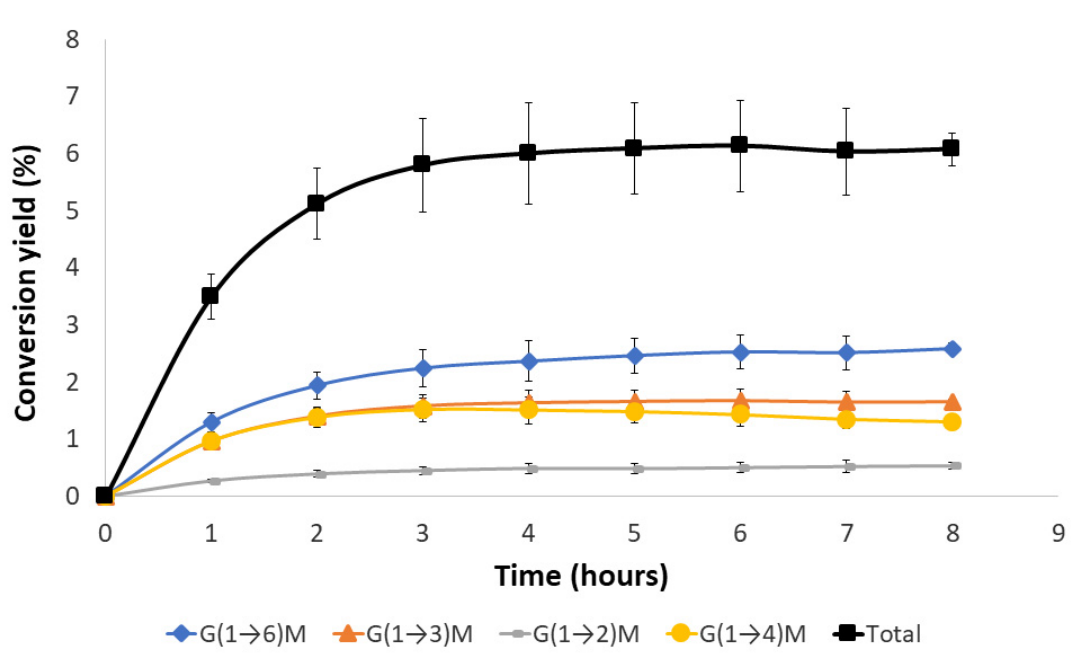
Figure 2. Transglycosylation kinetics between Gal f ‐ octyl (10 mM) and Man p ‐ p NP (60 mM) catalyzed by Ct Ara f 51 WT at 60 °C. The error bars represent the standard deviation of three independent experiments.